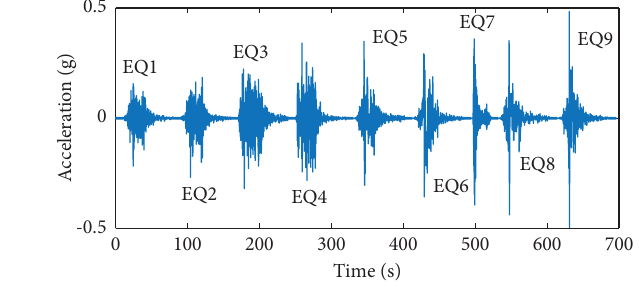
Figure 7: Loading protocol.